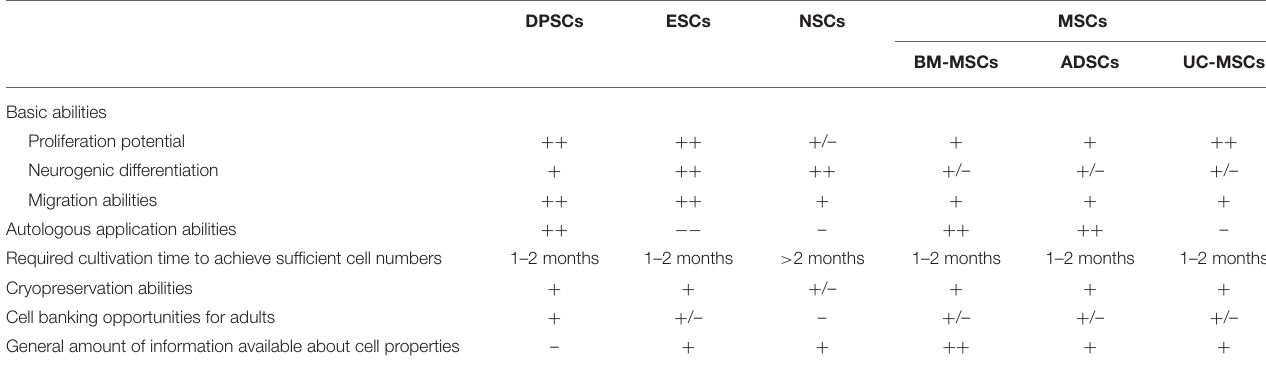
TABLE 4 | The comparison of DPSCs with other stem